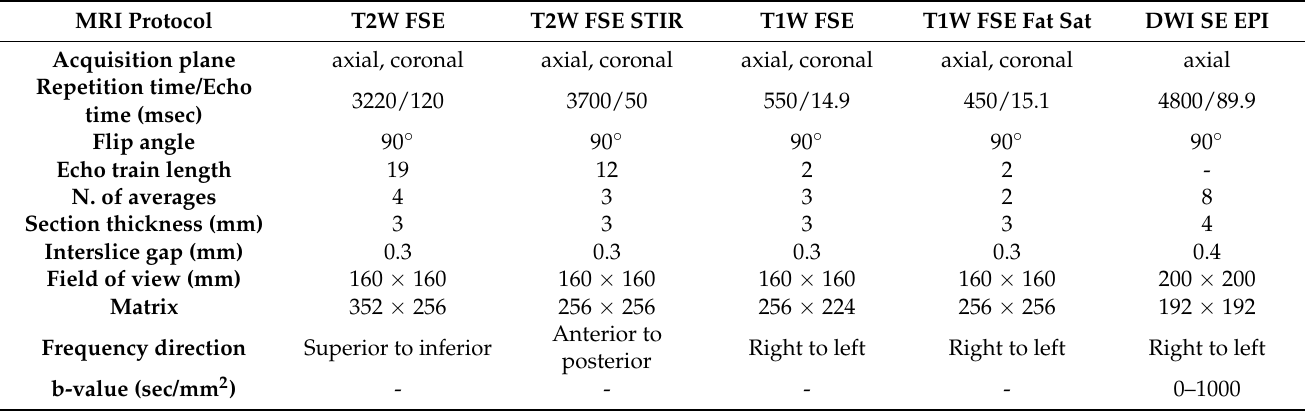
Table 1. Orbital MRI protocol. The synoptic table summarizes the imaging parameters of the MR sequences. T1-weighted FSE spectral presaturation sequences were performed before and after the intravenous administration of 0.2 mL gadoteric acid (gadoterate dimeglumine, Dotarem, 0.5 mol/L; Guerbet, Roissy, Charles-de-Gaulle Cedex; France) per kilogram of body weight. DW imaging sequence was performed before contrast medium administration. All sequences had a field of view that included orbital structures, lids, and the optic